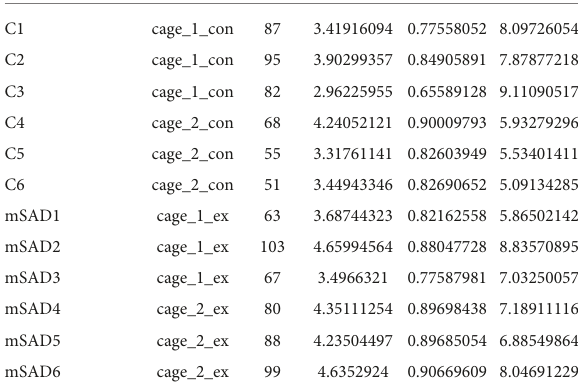
TABLE 3 Alpha diversity metrics were determined via QIIME2 diversity alpha plugin (QIIME_2, v2021.11), clustered according to cage_1_con (samples C1:C3, n = 3), cage_2_con (samples C4:C6, n = 3), cage_1_ex (samples mSAD1:mSAD3, n = 3), cage_2_ex (samples mSAD4:mSAD6, n = 3).